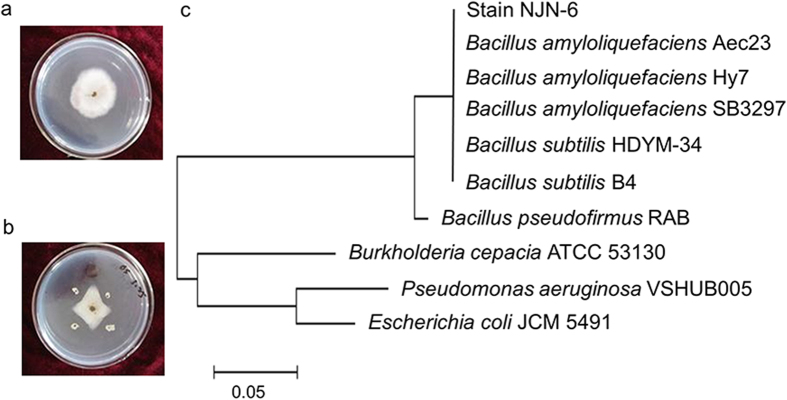
In-vitro antagonism against Fusarium oxysporum f. sp. cubense race 4 (FOC) by strain NJN-6.a) Control, FOC inoculated with sterilized water; b) antagonism against FOC by NJN-6; c) maximum composite likelihood phylogenetic tree of strain NJN-6.